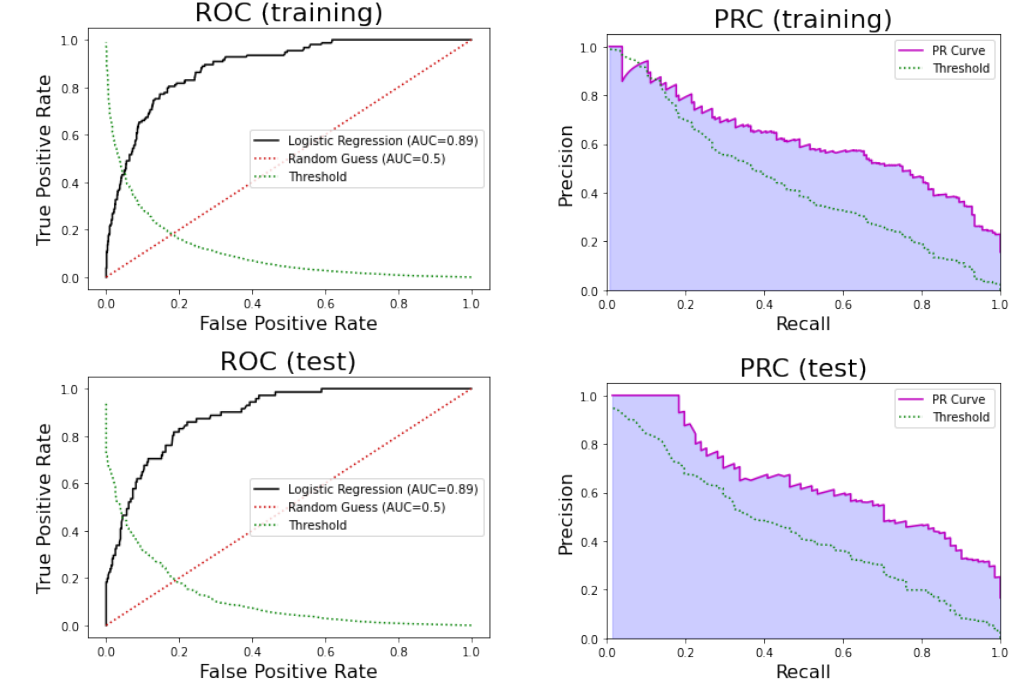
Figure 4. ( Top ) Receiver Operating Curve (ROC) of the logistic regression model in training ( left ) and Figure 4. Top: Receiver Operating Curve (ROC) of the Logistic Regression model in training (left) and testing ( right ). ( Bottom ) Precision-Recall Curve (PRC) in training ( left ) and testing ( right test (right). Bottom: Precision-Recall Curve (PRC) in training (left) and test (right). The coefficients, standard error and P-values for significance variables are shown in Table 2. 211